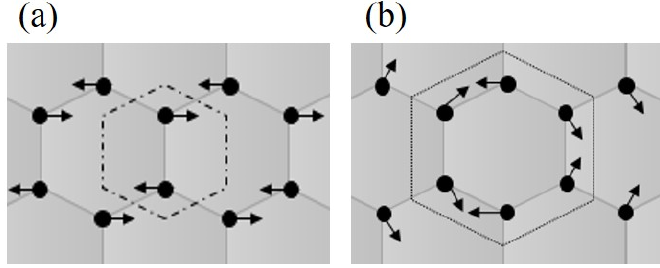
Figure 2. Vibration patterns with Mulliken notation. ( a ) Mode E2g. ( b ) Mode A1g.